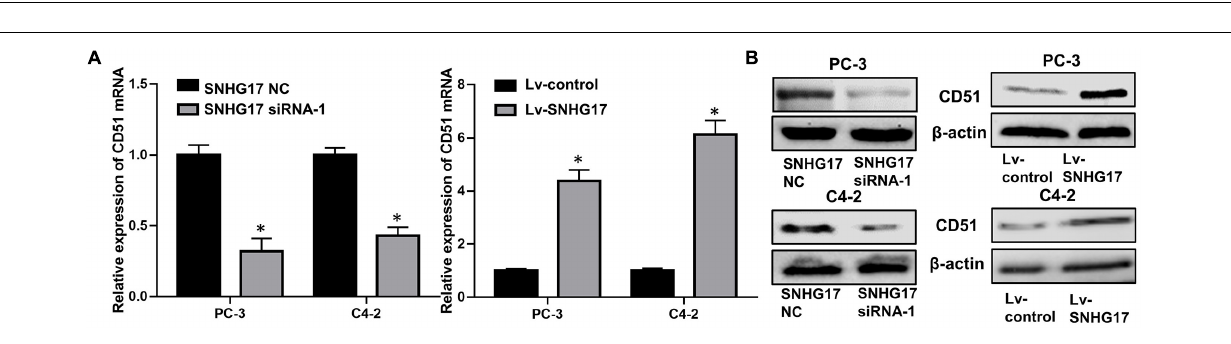
FIGURE 3 | SNHG17 promotes tumor growth and metastasis in CRPC in vivo . (A) Tumor growth curve of C4-2 cells infected with Lv-control and Lv-SNHG17; (B) Digital images of all the resected tumors in cells transfected with Lv-control ( n = 5) and Lv-SNHG17 ( n = 5) were captured after 18 days; (C) Tumor weight of C4-2 cells infected with Lv-control and Lv-SNHG17; (D) Ki-67 expression in nude mice bearing C4-2 cells infected with Lv-control and Lv-SNHG17; (E) Statistical analysis of the percentage of Ki-67 positive cells in nude mice bearing C4-2 cells infected with Lv-control and Lv-SNHG17; (F) HE staining of metastatic foci in the lungs of nude mice injected with C4-2 cells transfected with Lv-control or Lv-SNHG17; (G) Statistical analysis of the total number of metastatic foci in 10 fields per lung section of Lv-control or Lv-SNHG17 group. Data are shown as the mean ± S.E . * P < 0.05. The representative results of three independent experiments are shown.